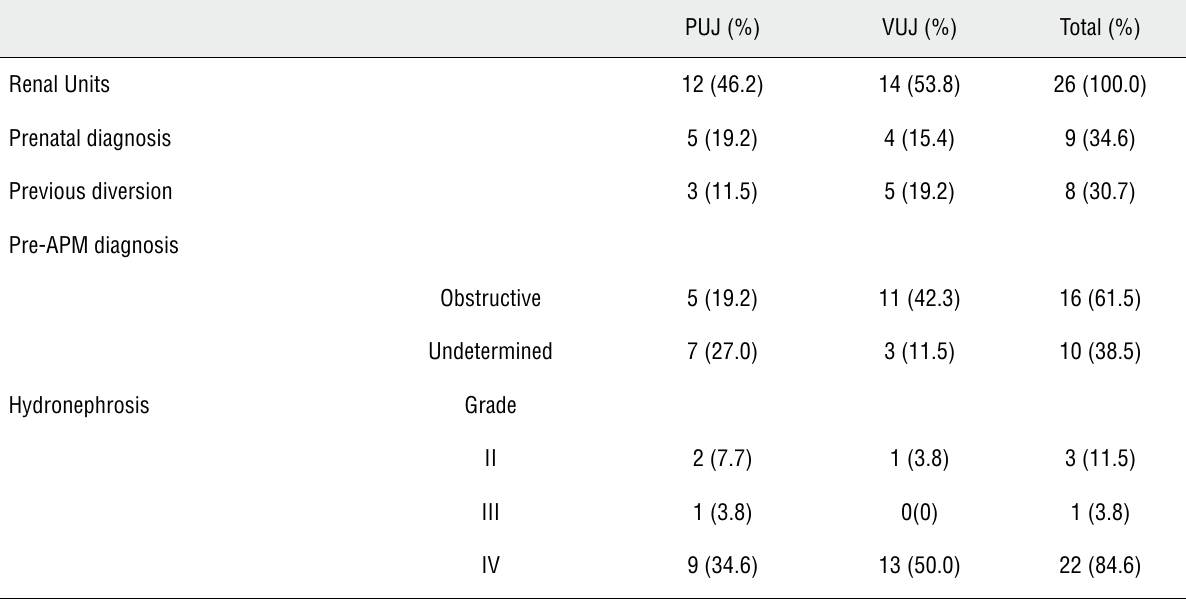
figure 1 - Measurement of the Antegrade Pressure of the Upper Urinary